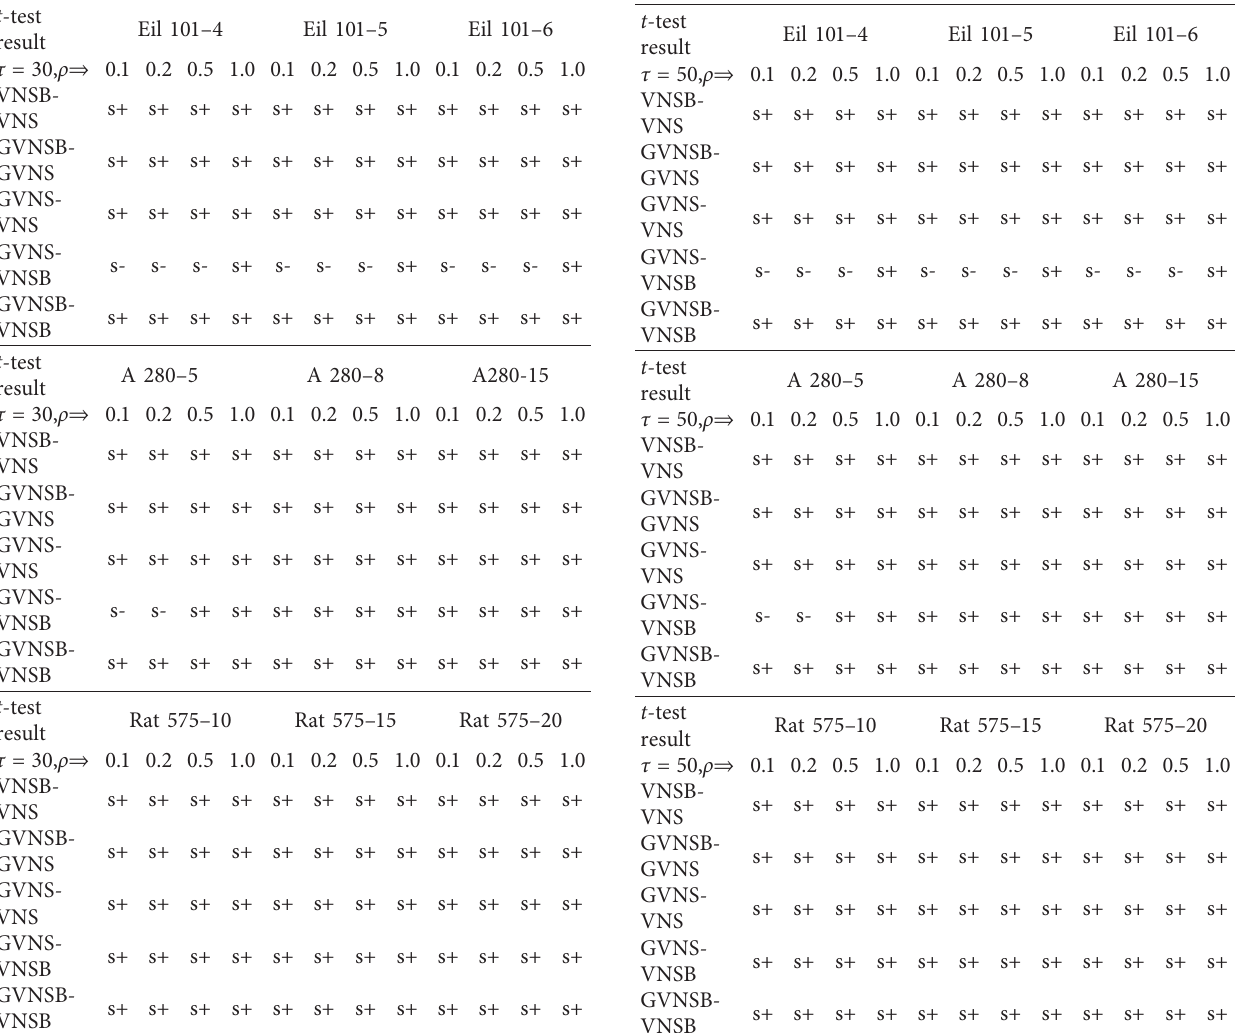
Table 1: t -test result of comparing VNSs in environment τ � 50. Table 2: t -test result of comparing VNSs in environment τ �